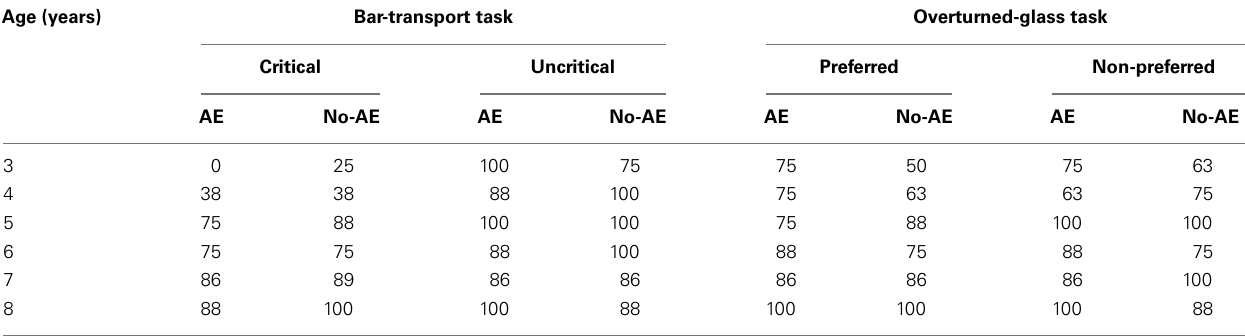
Table 1 | Percentages of end-state comfort in action effect (AE) groups and no-action effect (No-AE) groups in the bar-transport task and the overturned-glass